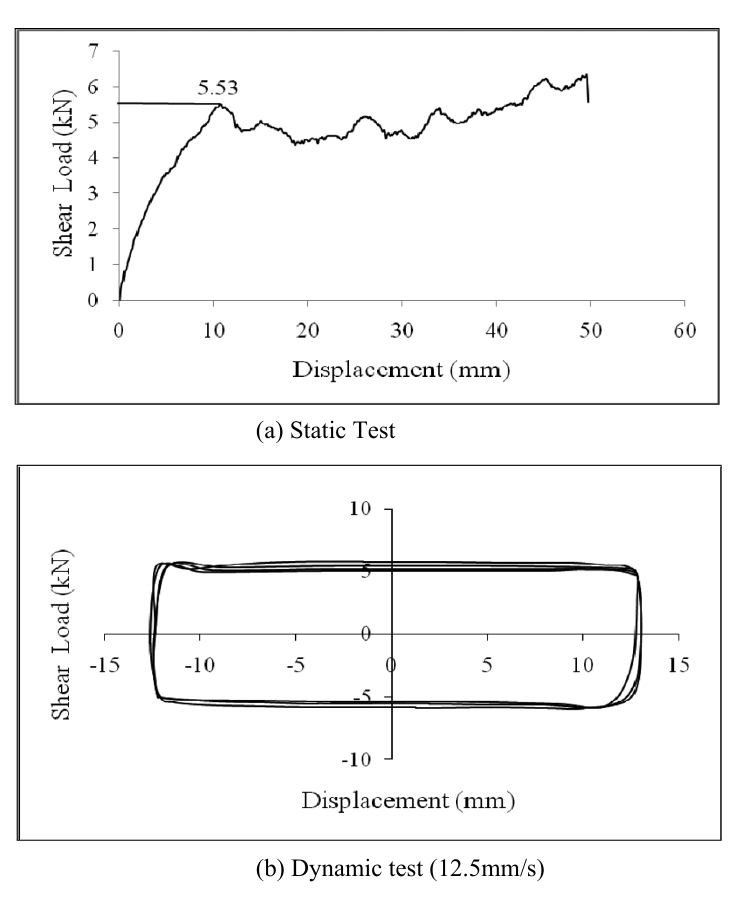
Fig. 4. Load-displacement graphs for static and dynamic test with 50 kN normal load (green